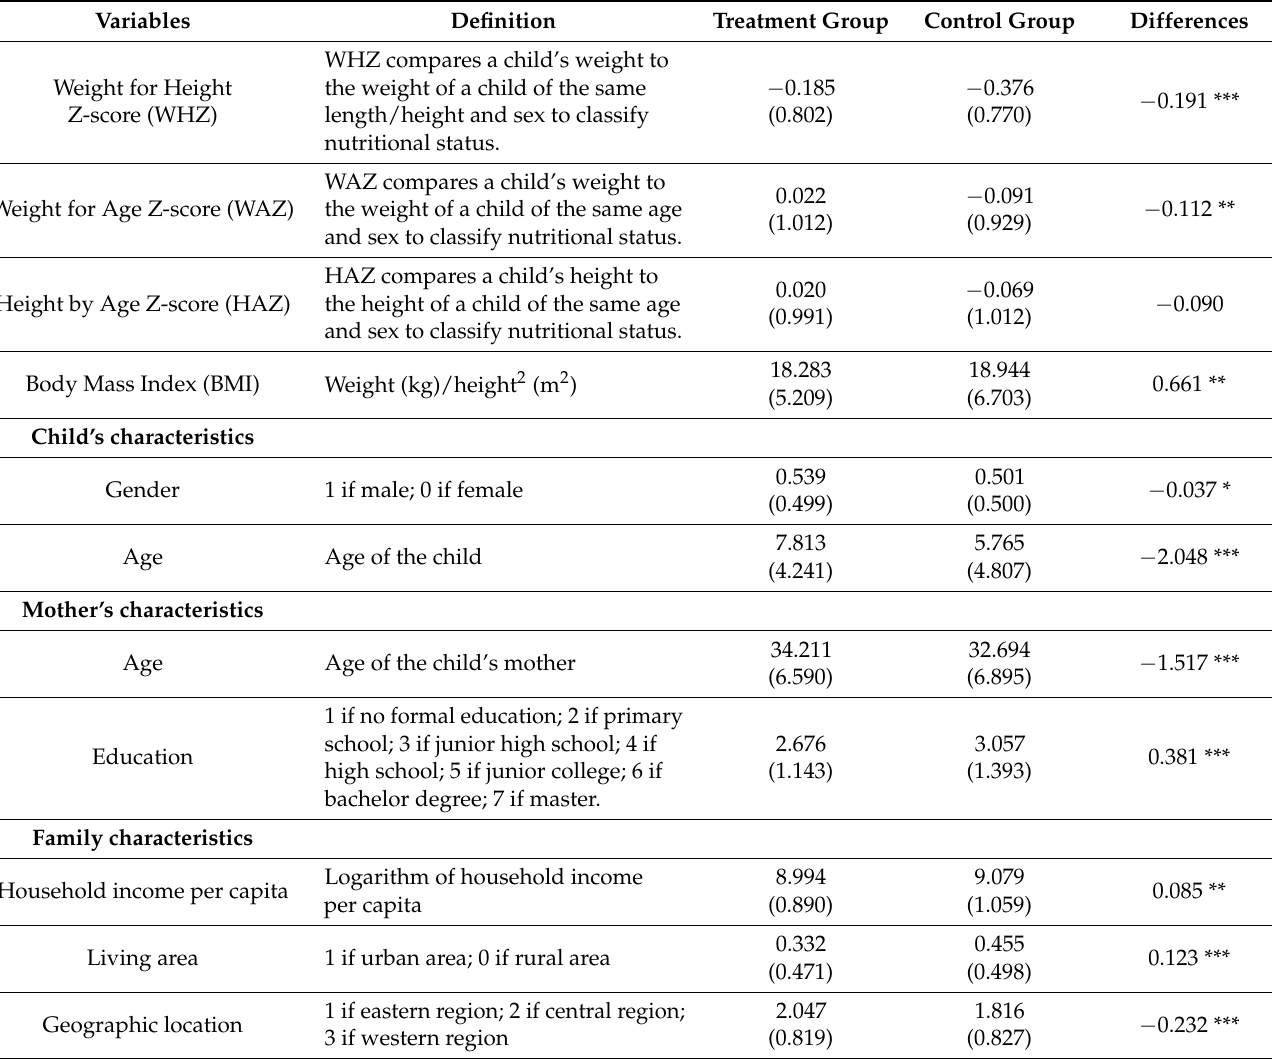
Table 1. Descriptive